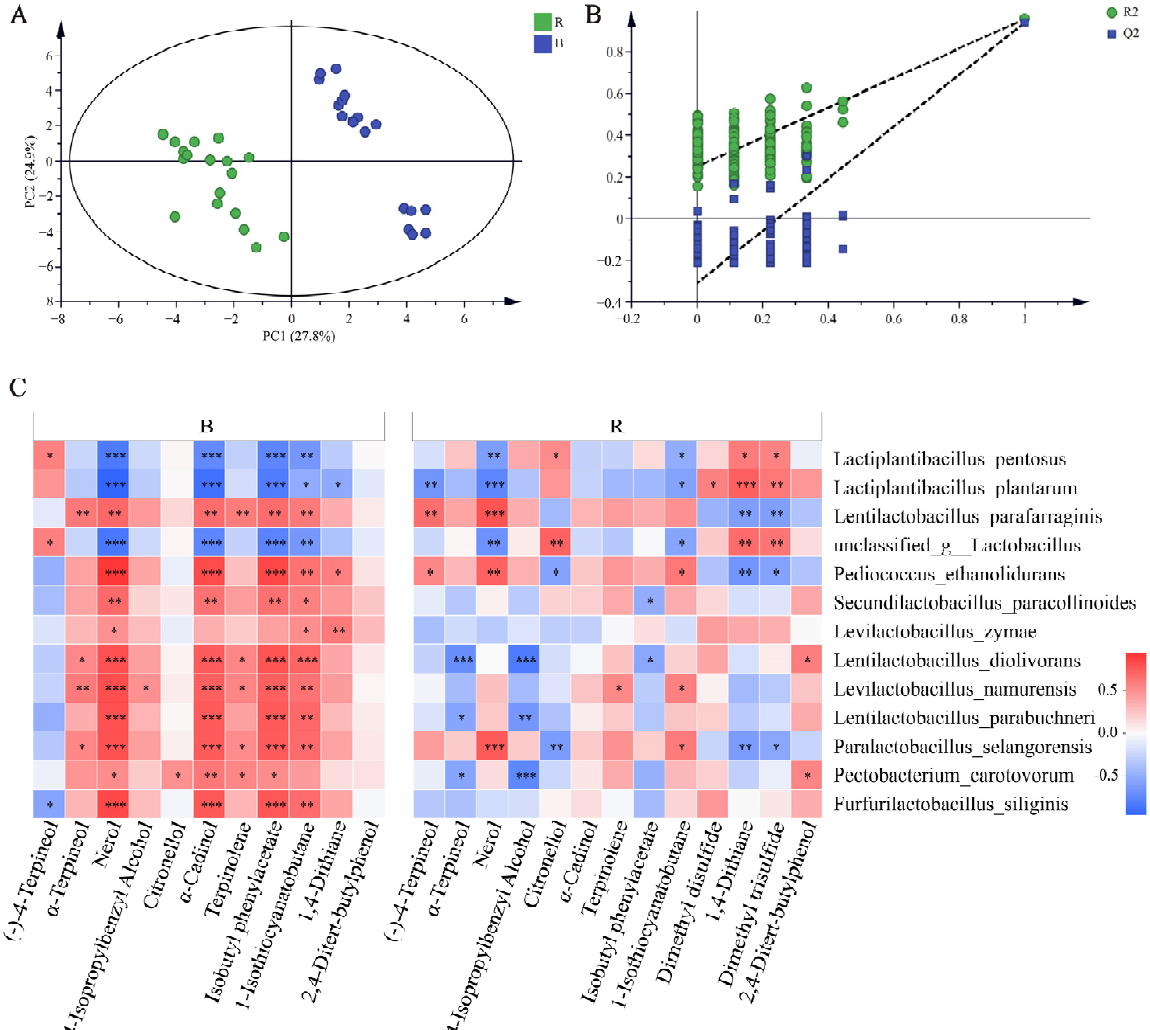
Figure 5. ( A ) PLS-DA score scatter plot and ( B ) permutation tests of VOCs. ( C ) Heatmap of correlation between microbial species (relative abundance exceeding 5% and the nine biomarkers previously identified) and different volatile flavor substances in the two kinds of paocai. R indicates red radish paocai, B indicates cabbage paocai. * 0.01 < p ≤ 0.05, ** 0.001 < p ≤ 0.01, *** p ≤ 0.001.